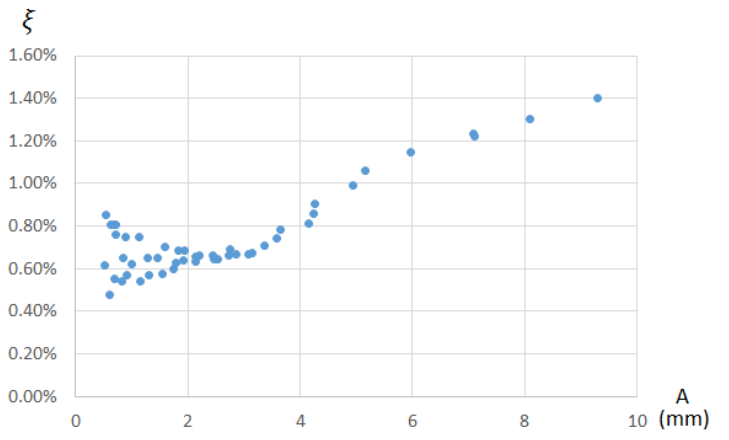
Figure 15. Value of the damping factor ξ according to the frame’s amplitude of free decay period in the case of clamped joints.